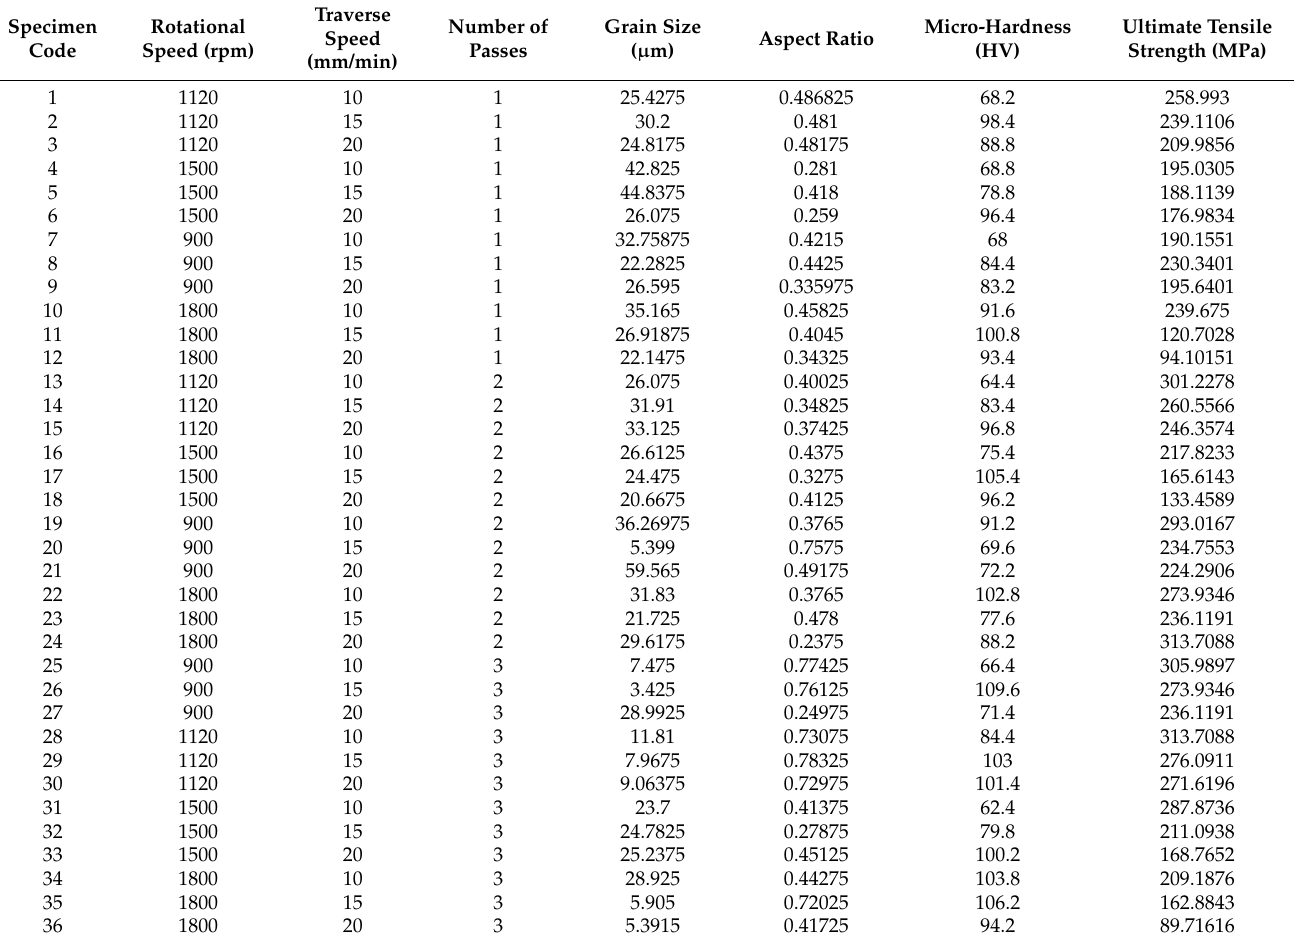
Table 3. Experimental